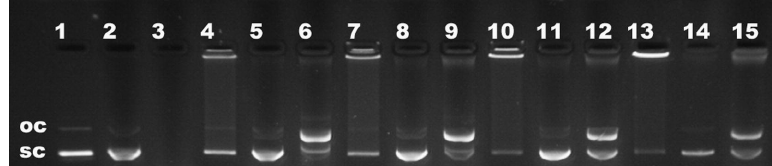
Figure 4. Binding efficiency between oligochitosans and DNA at differnet N/P ratios, and protection capacity from DNase I enzymatic digestion visualized by agarose gel electrophoresis. OC: open circular form, SC: supercoloid form. Lanes 1–3 correspond to free DNA; lanes 4–6, N/P 5; lanes 7–9, N/P 10; lanes 10–12, N/P 20; lanes 13–15, N/P